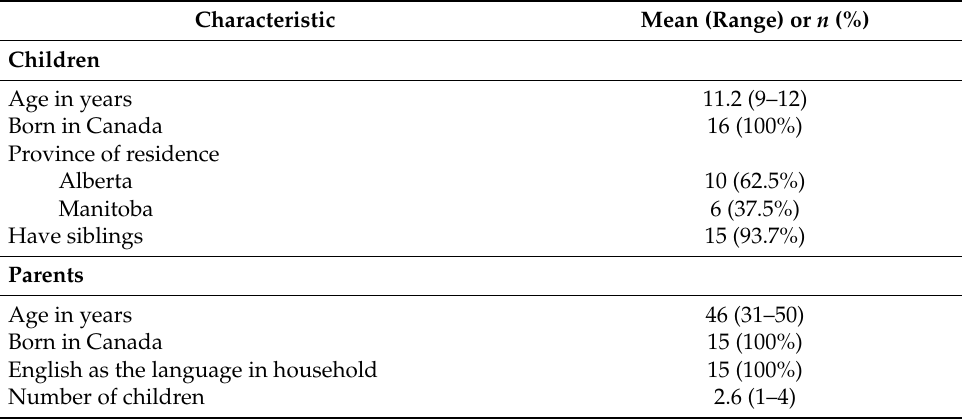
Table 1. Characteristics of Children ( n = 16) and Parents ( n =